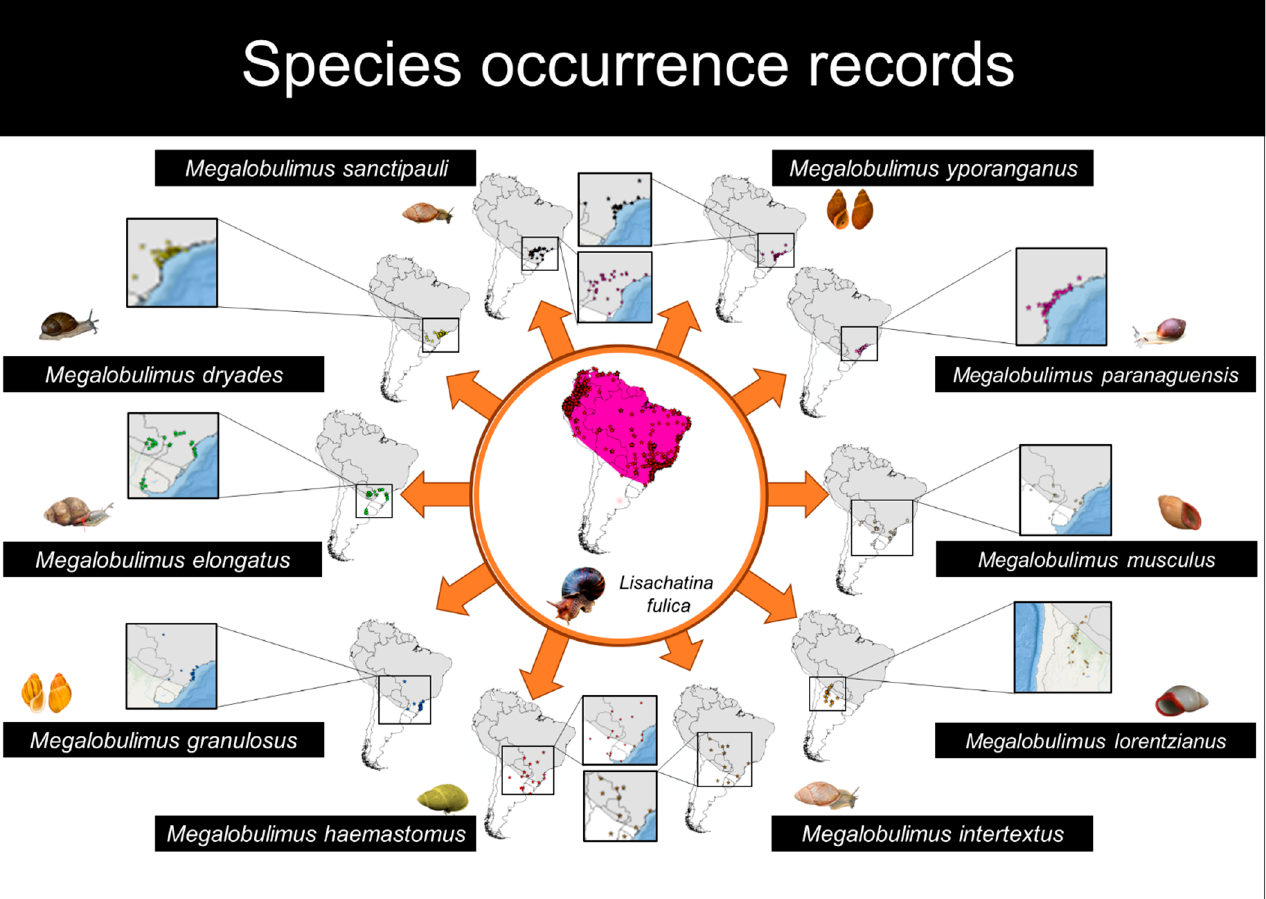
Figure 1. Occurrence records and spatial distribution maps of the ten species of Megalobulimus and Lissachatina fulica in South America. The gray minimum convex polygon of L. fulica is represented in the maps of the native species.